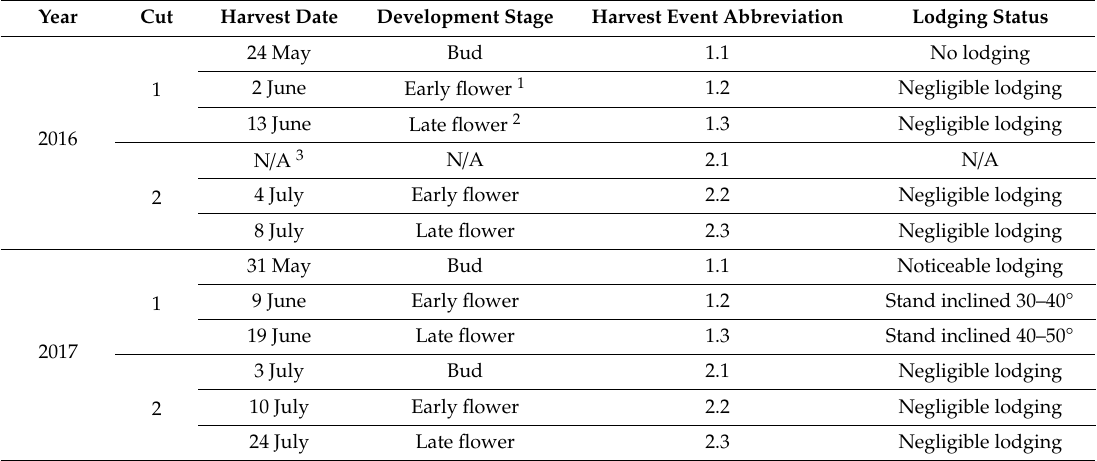
Table 1. Alfalfa harvest events over two